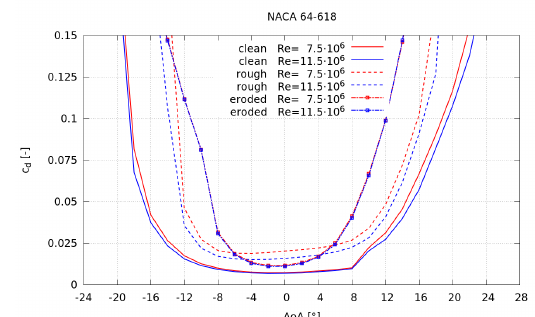
Figure 7. Numerical lift and drag coefficients of clean, rough, and eroded airfoils at Re = 7.5 × 10 6 and Re = 11.5 × 10 6 (“clean” refers to resolved boundary layer with transition model, whereas “rough” refers to the use of wall functions with fully-turbulent flow model and “eroded” refers to a changed leading edge shape with resolved boundary layer and fully-turbulent flow model).